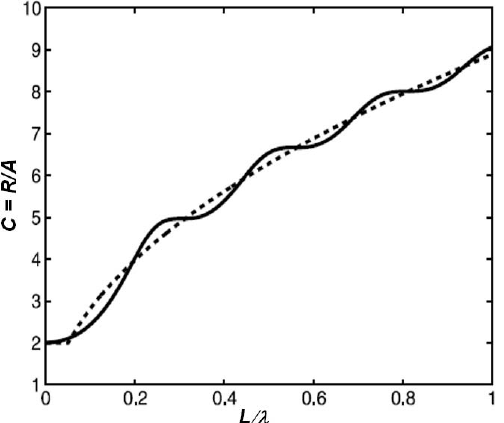
Fig. 1. Amplification run-up ratio: dashed line corresponds to the constant beach slope Eq. (4); solid line obtained for inclined beach matched with horizontal bottom Eq. (5).